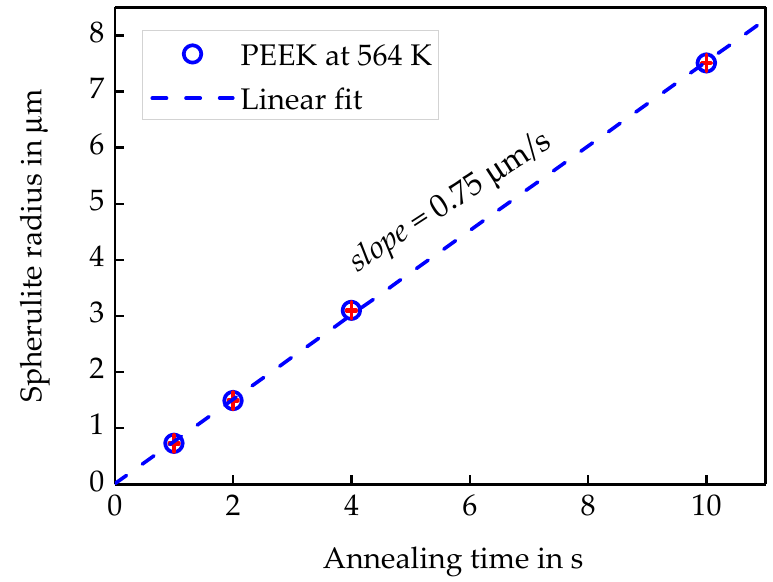
Figure 9. Surface spherulite radius vs. annealing time for PEEK at a sensor temperature of 564 K by AFM-FSC.